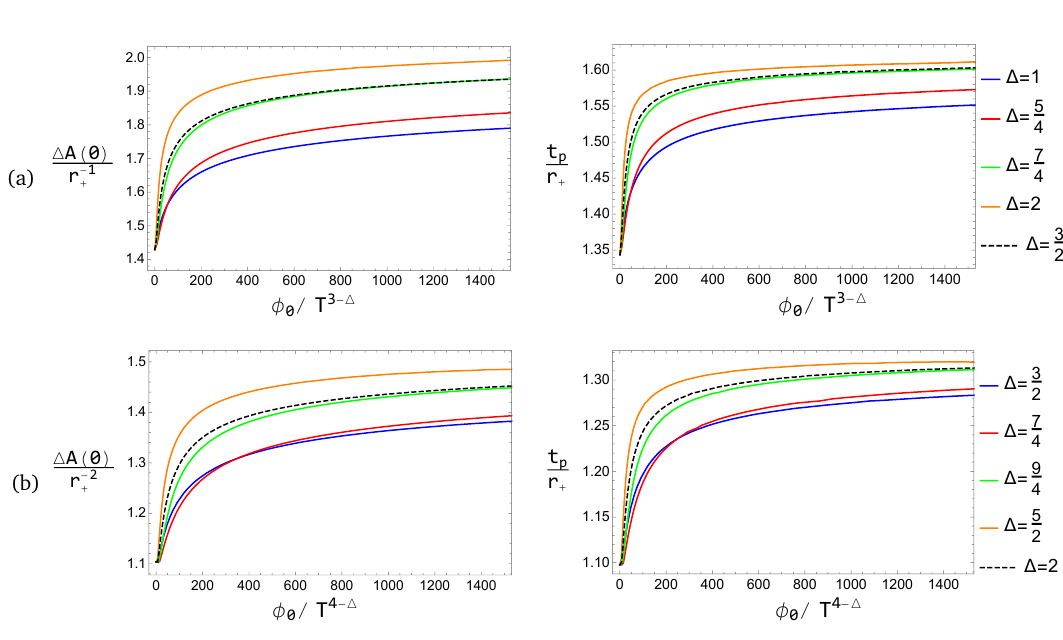
plotted as functions p +